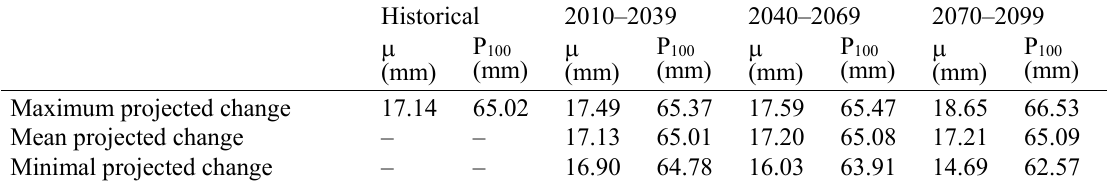
Table 1 Mean values and maximum precipitation to Tr = 100 years to different scenarios and different time periods.